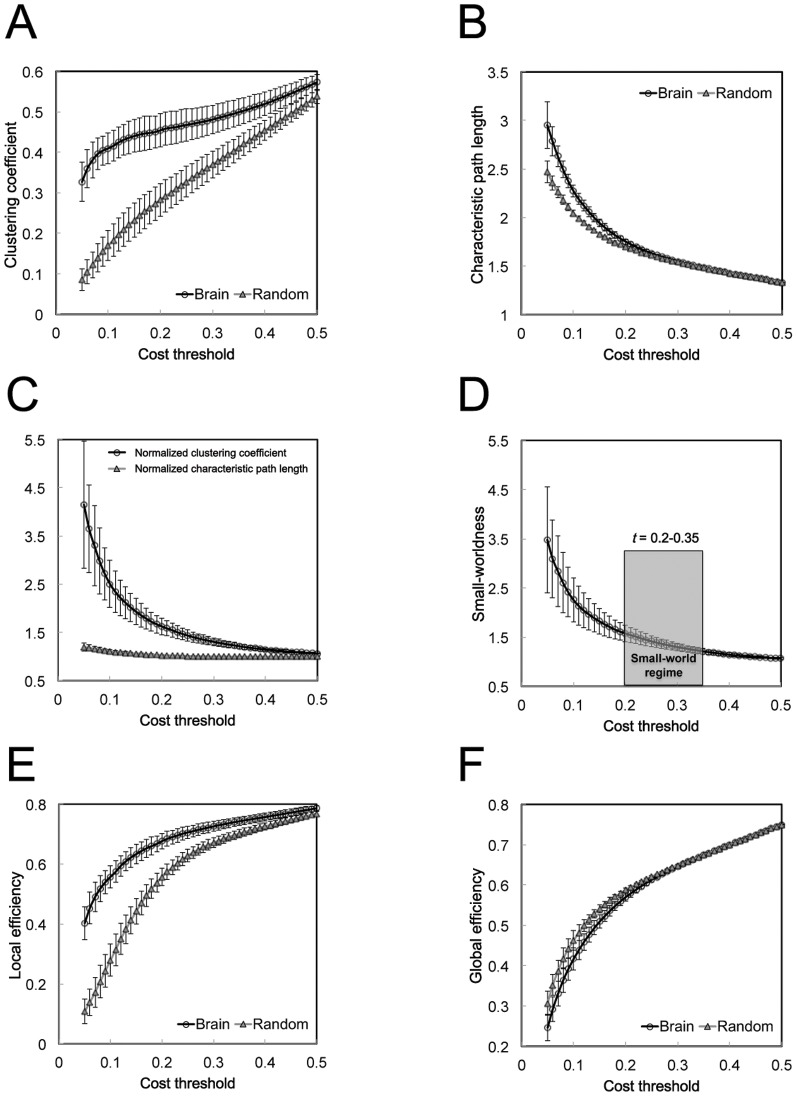
Global network properties.(A) The clustering coefficient and (B) the characteristic path length are shown as a function of cost thresholds and compared to the matched random networks. (C) The normalized clustering coefficient, the normalized characteristic path length, and (D) the small-worldness are shown as a function of cost thresholds. Note that the small-world regime of cost threshold adopted in this study was from 0.2 to 0.35. (E) The local efficiency and (F) the global efficiency are shown as a function of cost thresholds and compared to the matched random networks. Error bars indicate standard error in all subjects.